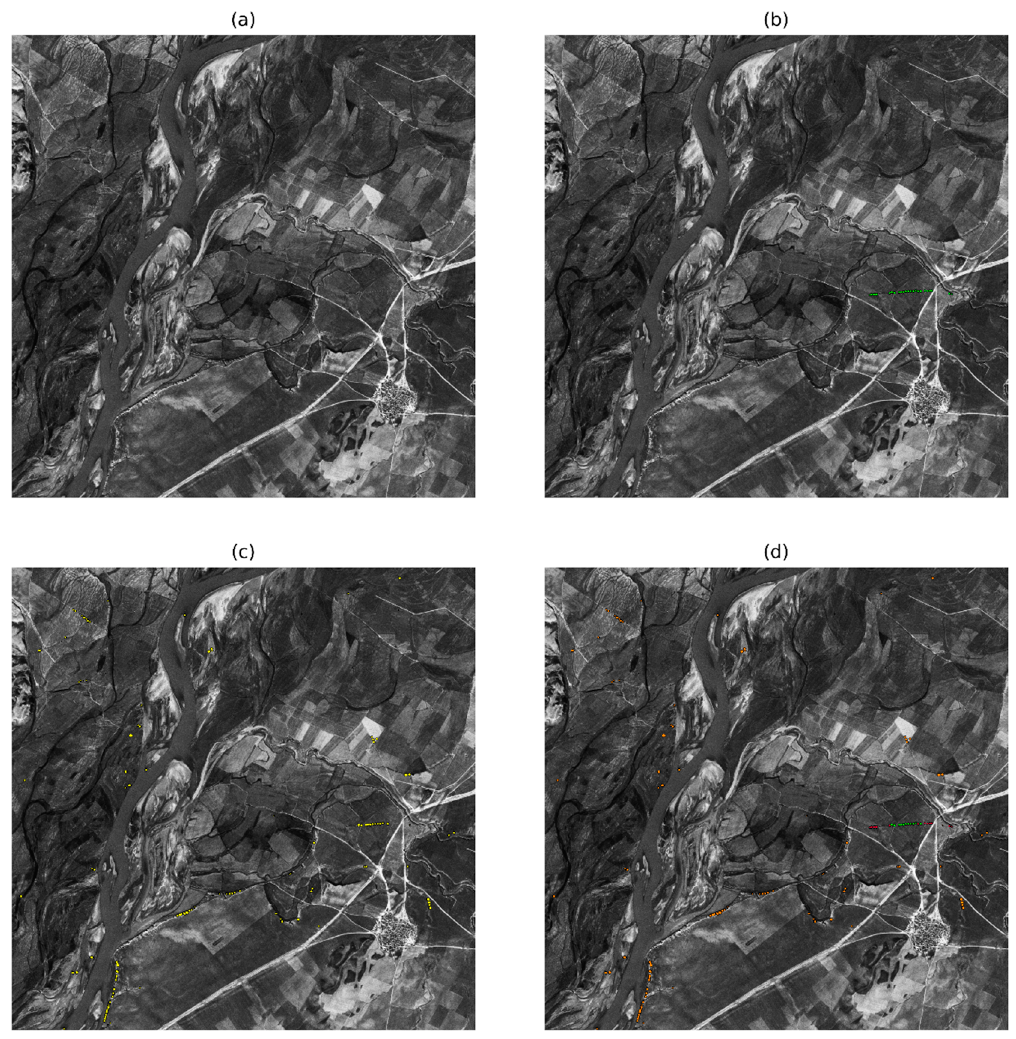
Figure 11. The lowest model performance was on patch 4 ( a ) with 23 labeled features, most with low annotation certainty resulting in the lowest precision score (0.107) and very low recall score (0.478). ( b ) Annotated shafts (green), ( c ) predicted shafts (yellow), ( d ) evaluation: TP (green), FP (orange), FN (red). Annotated shafts are only in the center-right part of the image ( b ), while FP are spread across the lower half of the patch ( c ). Each patch is 2000 × 2000 pixels (approximately 5.5 × 5.5 km).